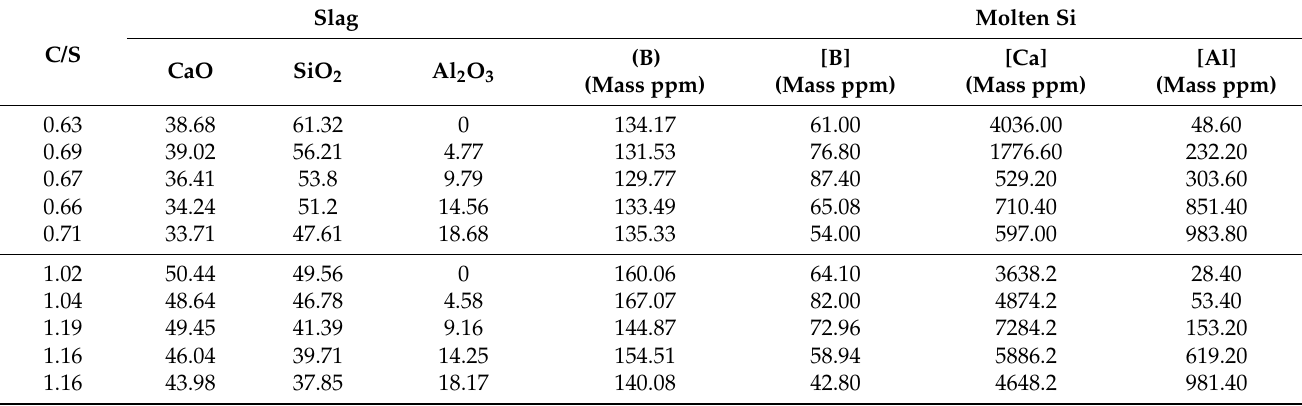
Table 2. Components of slag and Si after 4 h at 1823 K, (mass%, mass